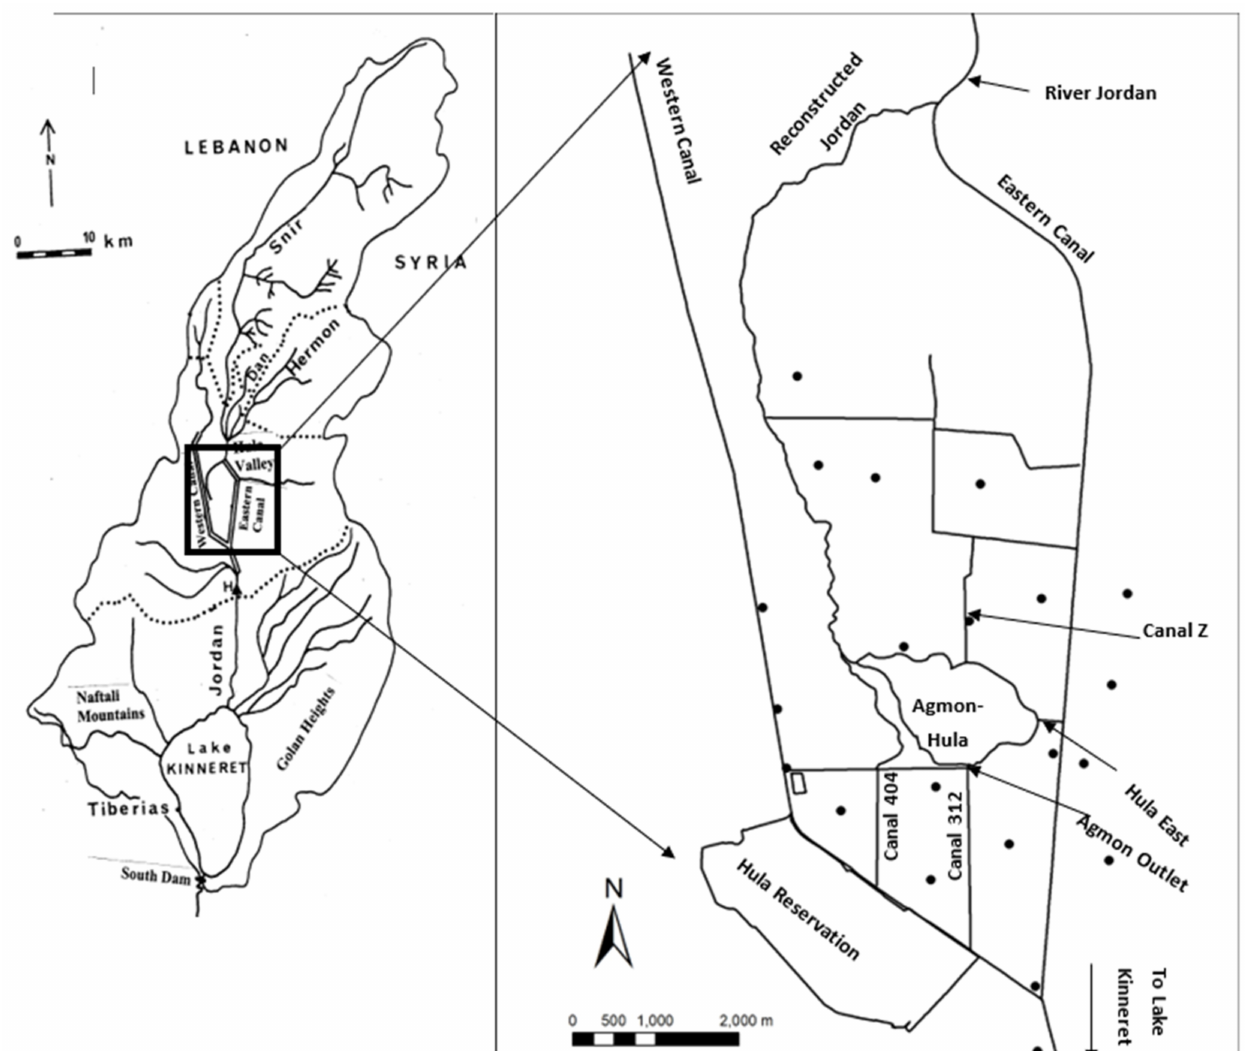
Figure 1. Geographical maps of the Lake Kinneret watershed with inflow rives ( left ) and the Hula Valley ( right ). Bore holes drills are indicated (black